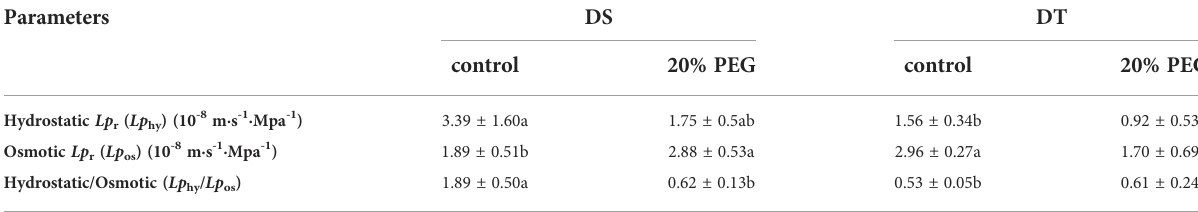
TABLE 3 Hydrostatic and osmotic hydraulic conductivity ( Lp r ) in drought-tolerant (DT) and drought-sensitive (DS) genotypes grown under control or osmotic stress conditions.